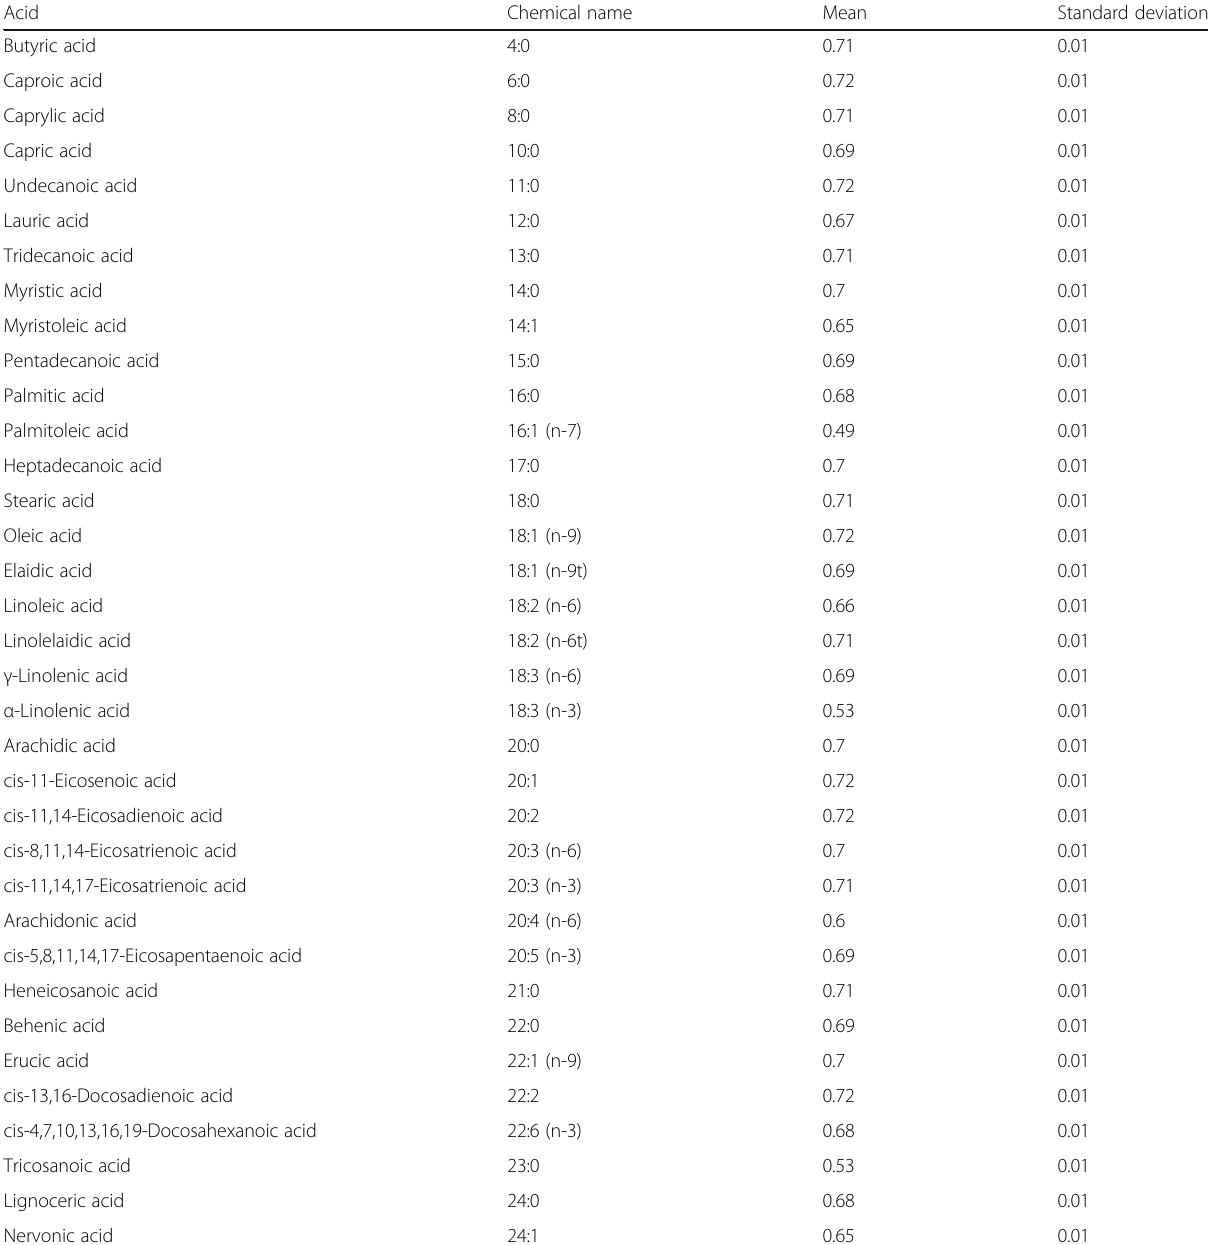
Table 1 Impedance in free fatty